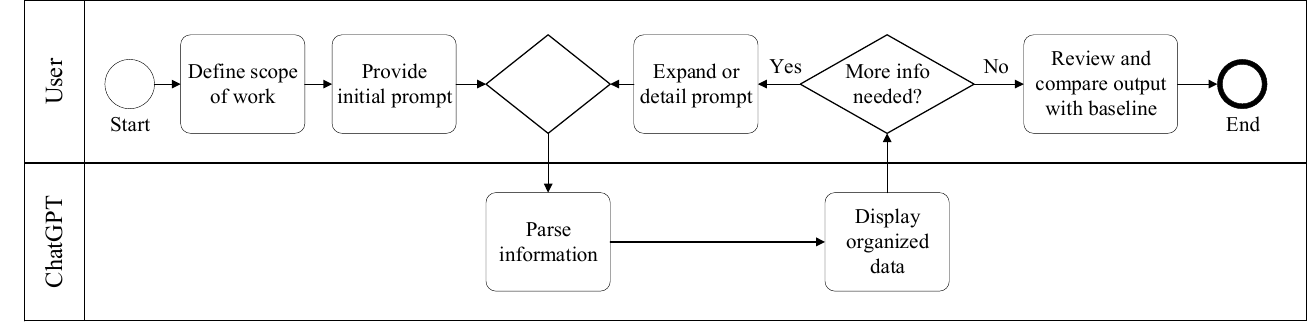
Figure 1. Overview of the main steps for using and assessing ChatGPT in this study.